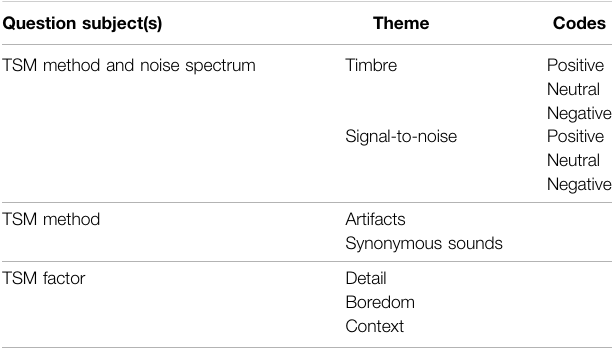
TABLE 1 | Themes and codes from the qualitative